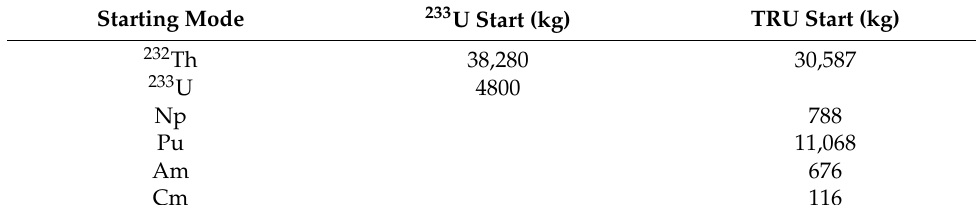
Table 4. Initial heavy nuclei inventories of different MSFR starting modes.